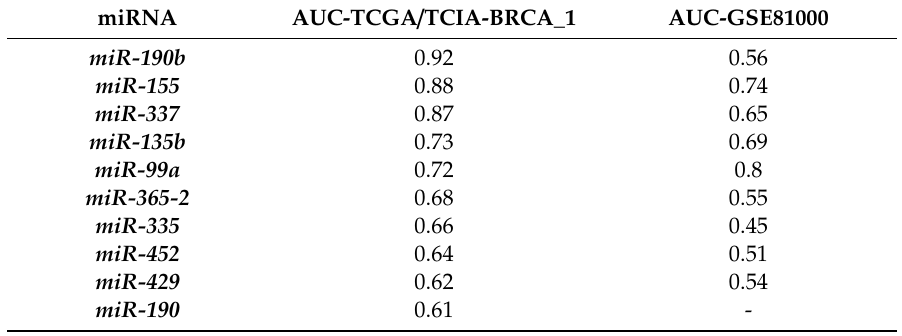
Table 1. Results of the classification of miRNAs in TCGA / TCIA-BRCA_1 and GSE81000